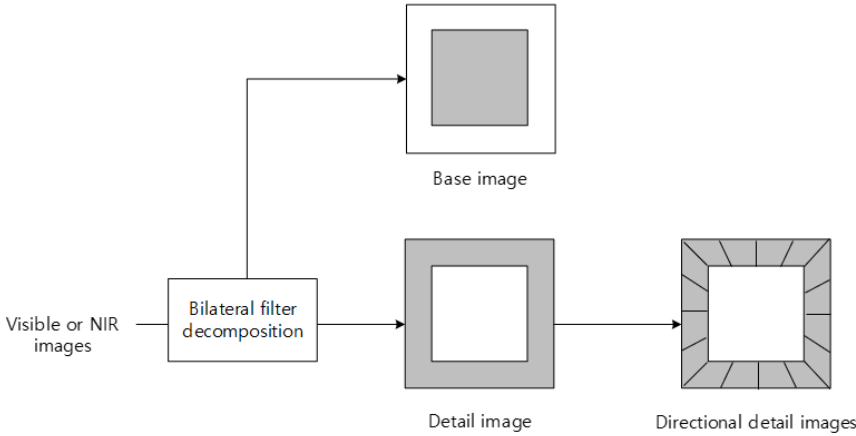
Figure 2. Directional detail image extraction using the contourlet filter.